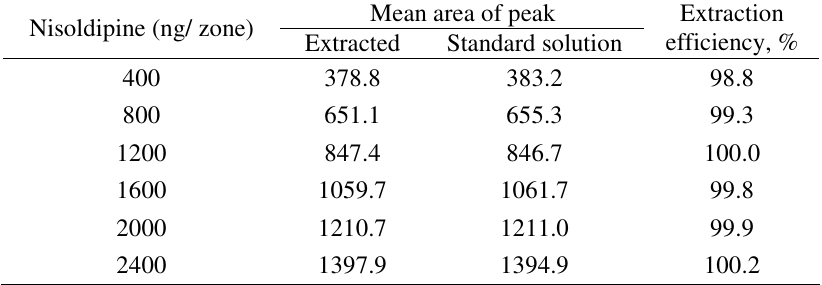
Table 3. Extraction efficiency of nisoldipine at various